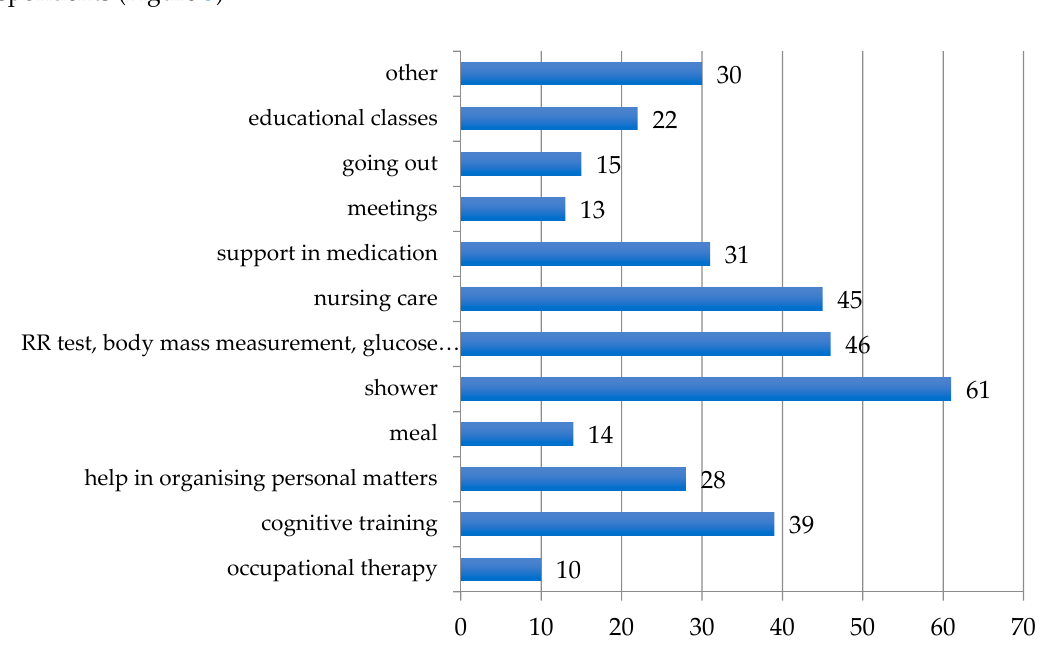
Figure 2. Assessment of the significance of services in the opinion of attendees of day care centres in Poland.